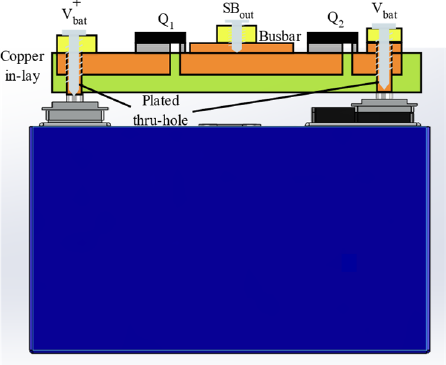
Figure 5. Smart Battery hardware design concept for high Ah prismatic